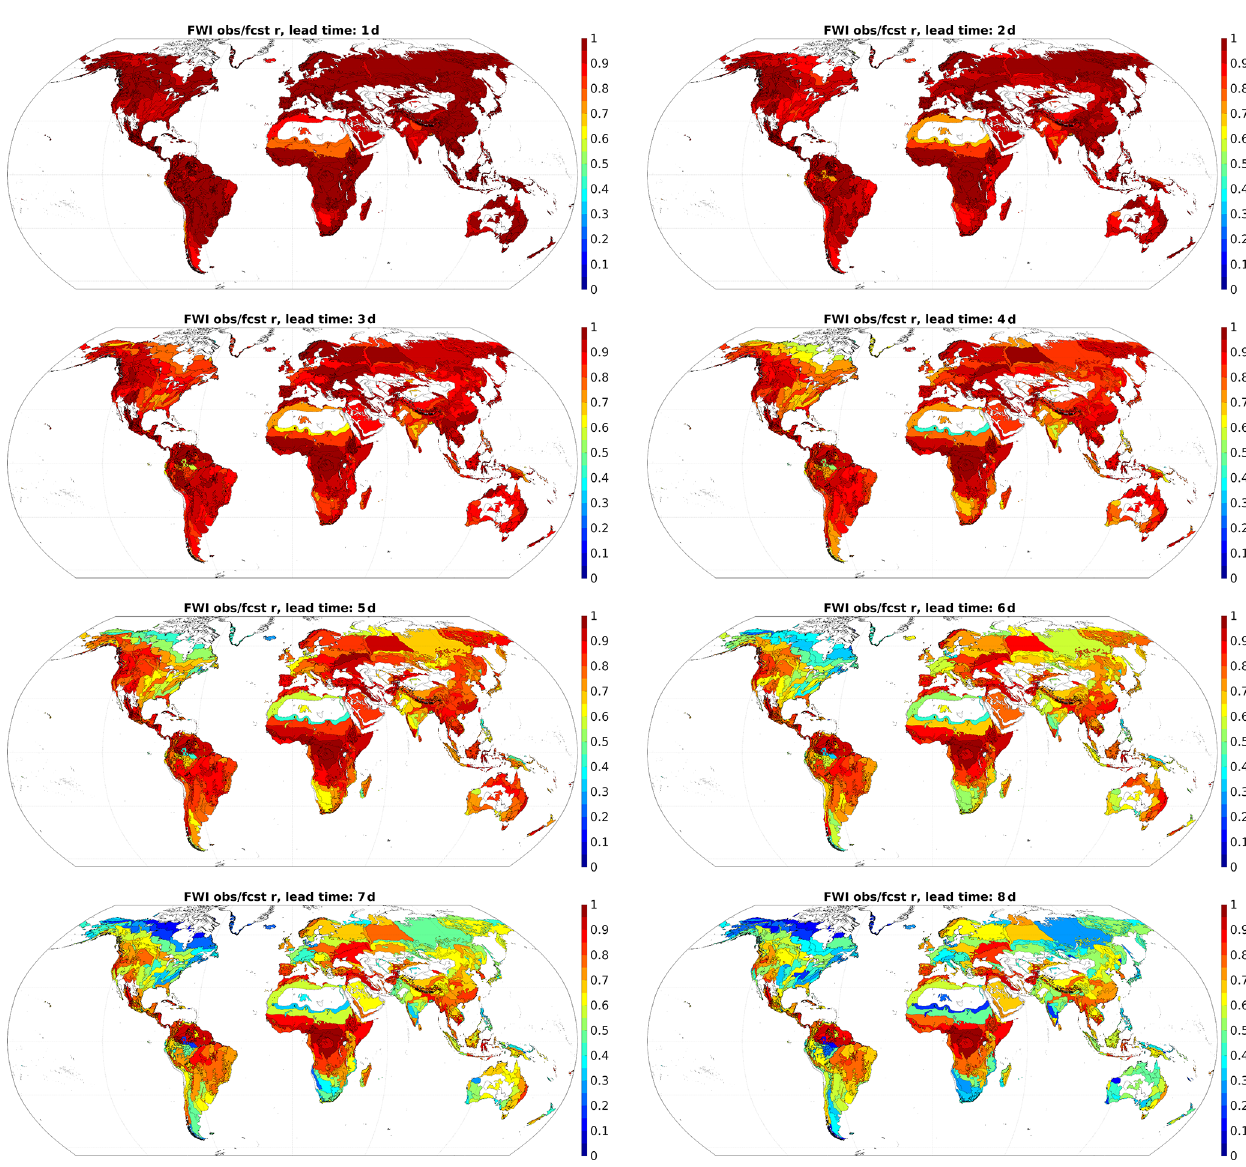
Figure 11. Correlation ( r ) between daily analysis (obs) and forecast (fcst) FWI for 2018 at lead times of 1 to 8d, for GEOS-5 grid points averaged within each of 771 Terrestrial Ecoregions of the World. Correlations are calculated only over the local fire season in each ecoregion, defined as the 4-month period with the highest mean